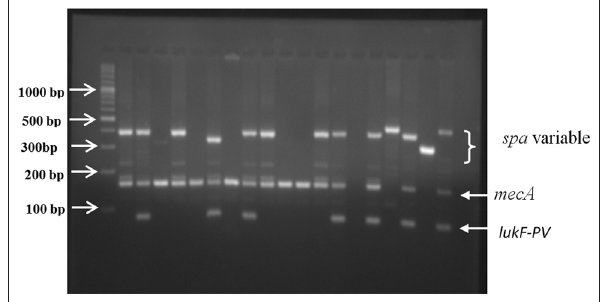
Figure-1: Agarose gel electrophoresis analysis showing multiplex polymerase chain reaction amplification products for the detection of the lukF-PV gene (85 bp). The Lanes 2, 6, 8, 13, 14, and 16 show the lukF-PV gene (85 bp) in the methicillin-resistant Staphylococcus aureus isolates. P = Positive control lukF-PV-positive S. aureus , N = Negative control. Table-3: Multidrug resistance profile of PVL-positive isolates. Antimicrobial agent